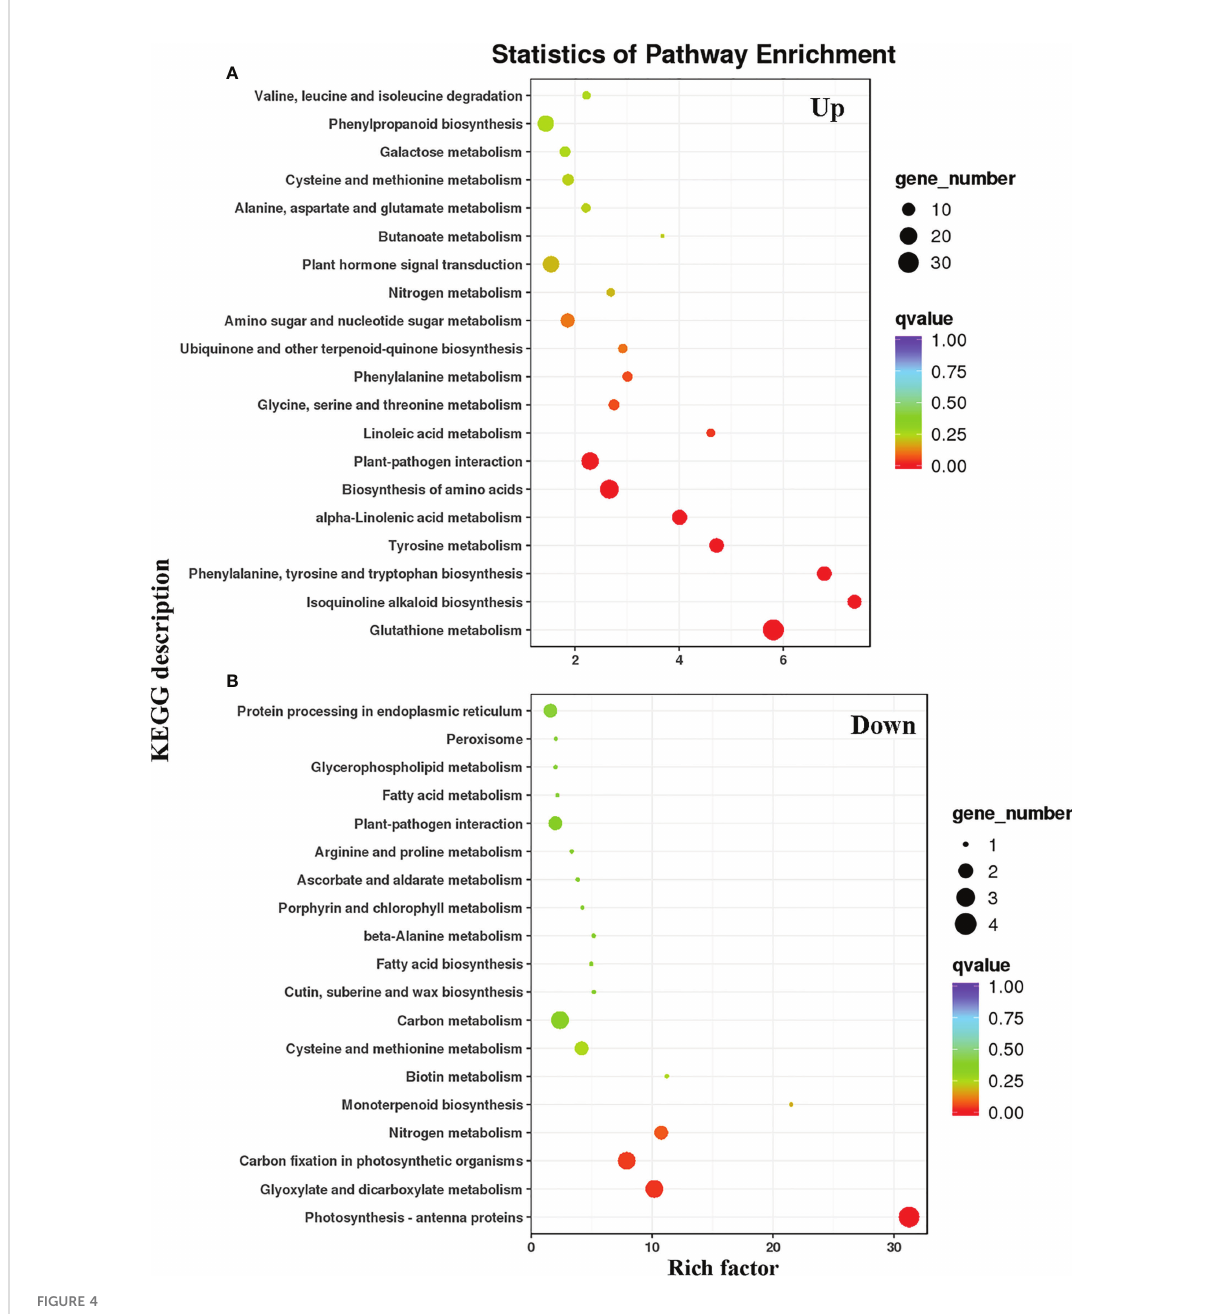
FIGURE 4 KEGG pathways of prominently enriched differentially expressed genes (DEGs) in WT and LMM 5386 lines. (A) upregulated differentially expressed genes (DEGs); (B) downregulated differentially expressed genes